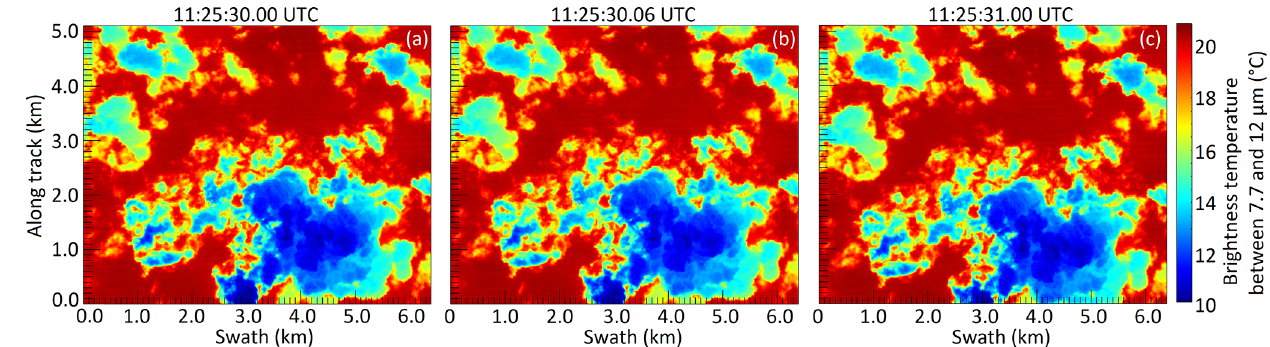
Figure 8. The 2D fields of brightness temperature measured at a flight altitude of approximately 10km with the VELOX broadband chan- nel between 7.7 and 12µm during the EUREC 4 A field campaign on 5 February 2020 at (a) 11:25:30.00UTC, (b) 11:25:30.06UTC, and (c)